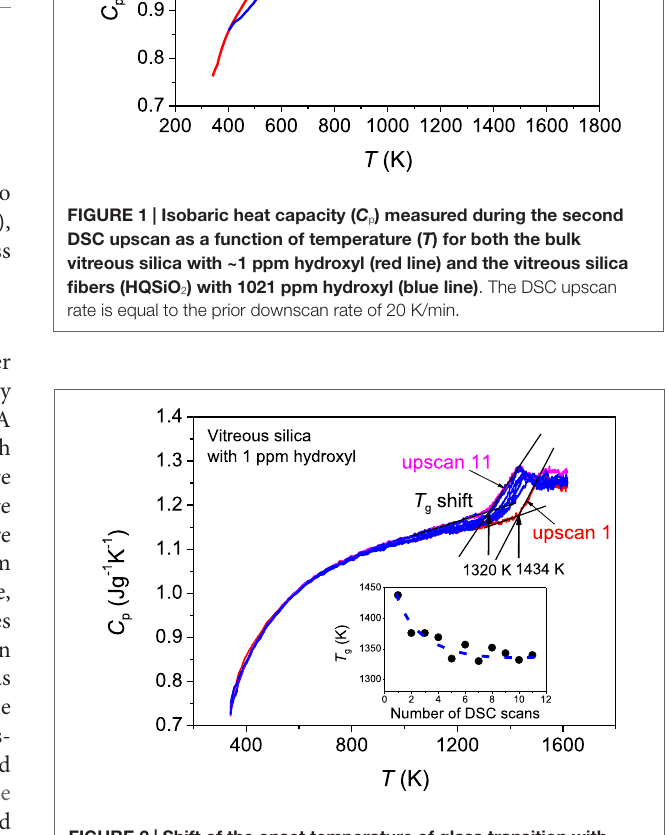
FigUre 2 | shift of the onset temperature of glass transition with repeating the Dsc up- and downscan at 20 K/min . The upscan curves 1–11 for the bulk vitreous silica with 1 ppm hydroxyl are shown and the downscan curves are not shown. Inset: the T g drop trend with increasing the number of DSC scans. The dashed line is guide for eyes.